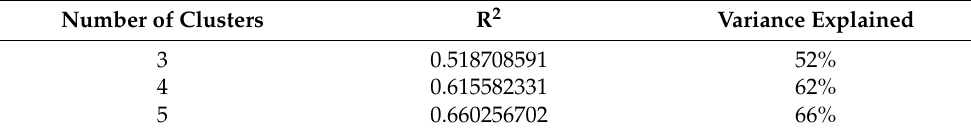
Table 1. Cluster analysis and explained variance of each of the solutions. Number of